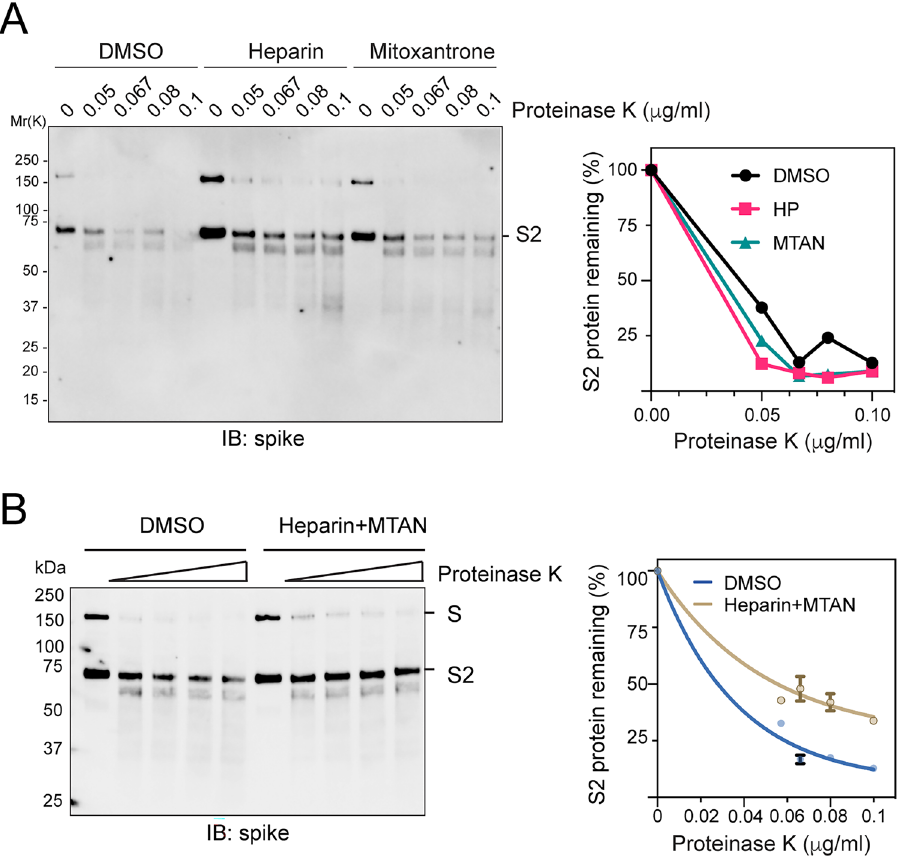
Figure 2. Heparin and Mitoxantrone collectively reduce protease sensitivity of spike. (A) Either heparin or Mitoxantrone alone does not affect the protease sensitivity of spike. Spike ECD incubated with heparin (25 μM) or Mitoxantrone (25 μM) or with a buffer control was treated with increased concentrations of proteinase K for 10 min. The samples were analyzed by immunoblotting with spike antibodies. The graph shows the quantification of the S2 band in (A) . (B) Heparin binding in the presence of Mitoxantrone increases the protease resistance of spike. As in (A) , except that spike was treated with heparin and Mitoxantrone together before proteolysis. The graph shows the quantification of the S2 band in (B) . n = 3 independent experiments. Error bars,